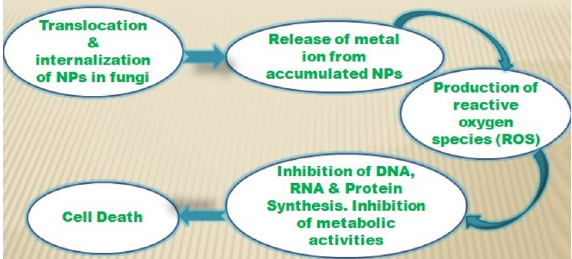
Figure 2. Flow chart representing mode of mechanism of NAFO nanoparticles against